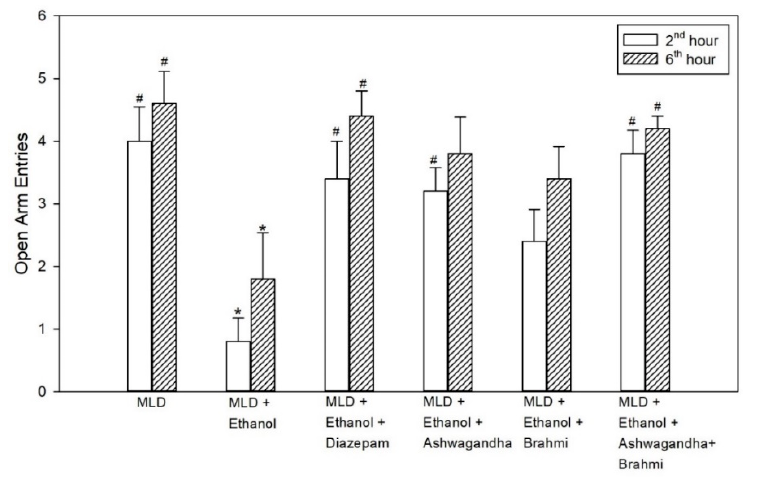
Figure 4. Effect of test drugs on anxiety represented by the number of open arm entries in elevated maze test at 2nd hour and 6th hour of alcohol withdrawal in rats. (‘*’ represents statistically significant compared with MLD group. ‘#’ represents statistically significance compared with MLD + Ethanol group.). Table 2. Elevated plus maze first entry in different groups at 2nd and 6th hour of alcohol with- drawal.